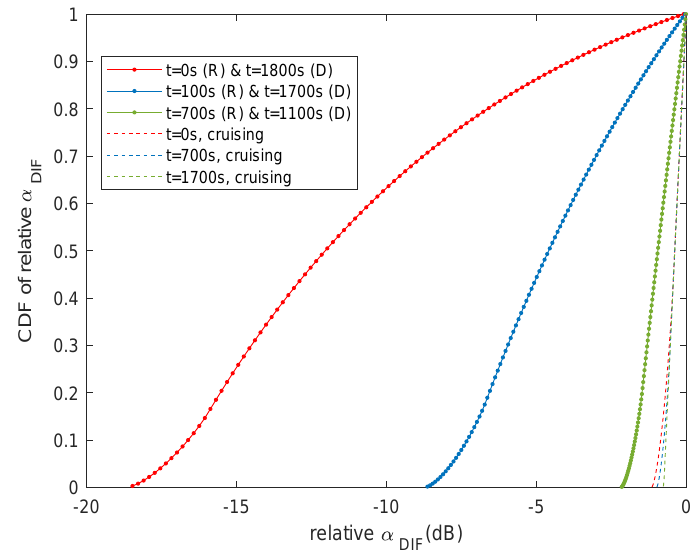
Figure 13. The CDF of relative path attenuation.